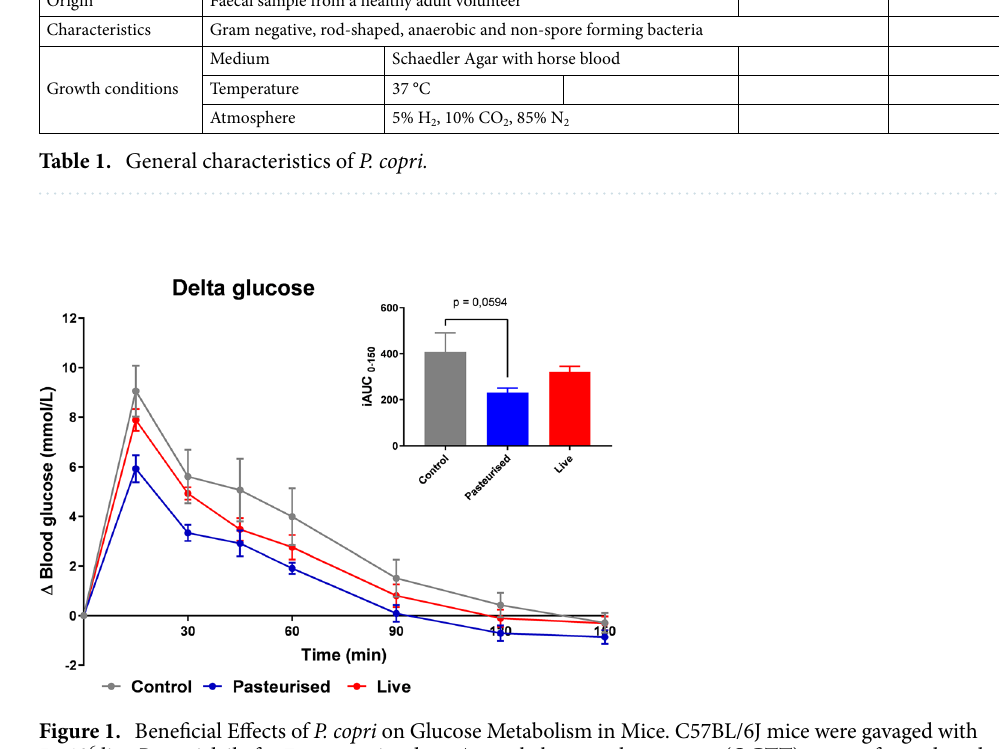
Figure 1. Beneficial Effects of P. copri on Glucose Metabolism in Mice. C57BL/6J mice were gavaged with 5 × 10 6 live P. copri daily for 7 consecutive days. An oral glucose tolerance test (OGTT) was performed on day 7 showing that both live and pasteurized P. copri improve glucose tolerance (n =